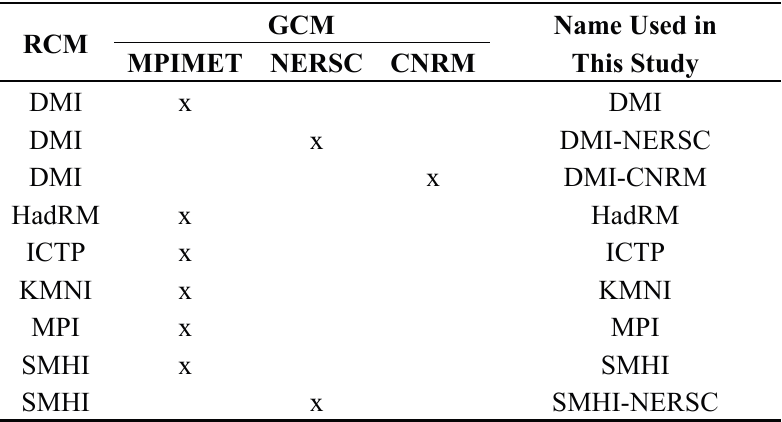
Table 2. Coupled GCM-RCM simulations from ENSEMBLES Project used in this